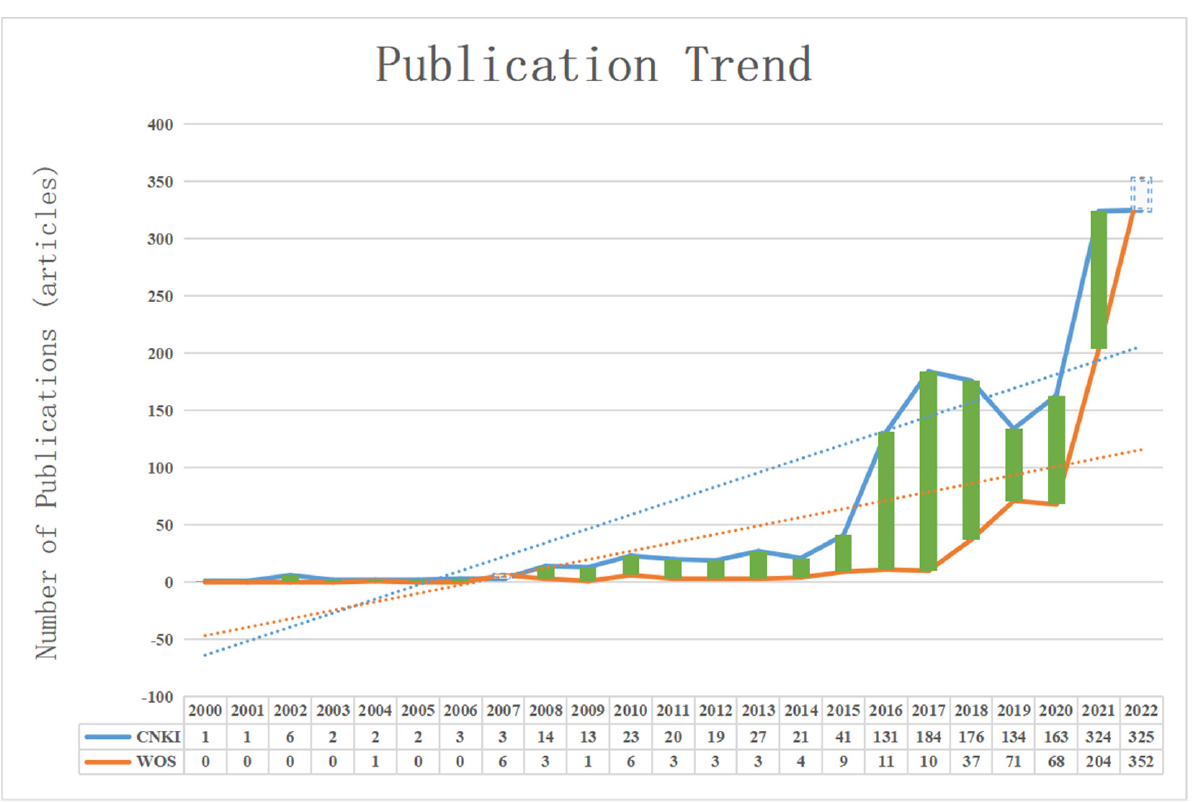
Figure 2. Trends in the publications.